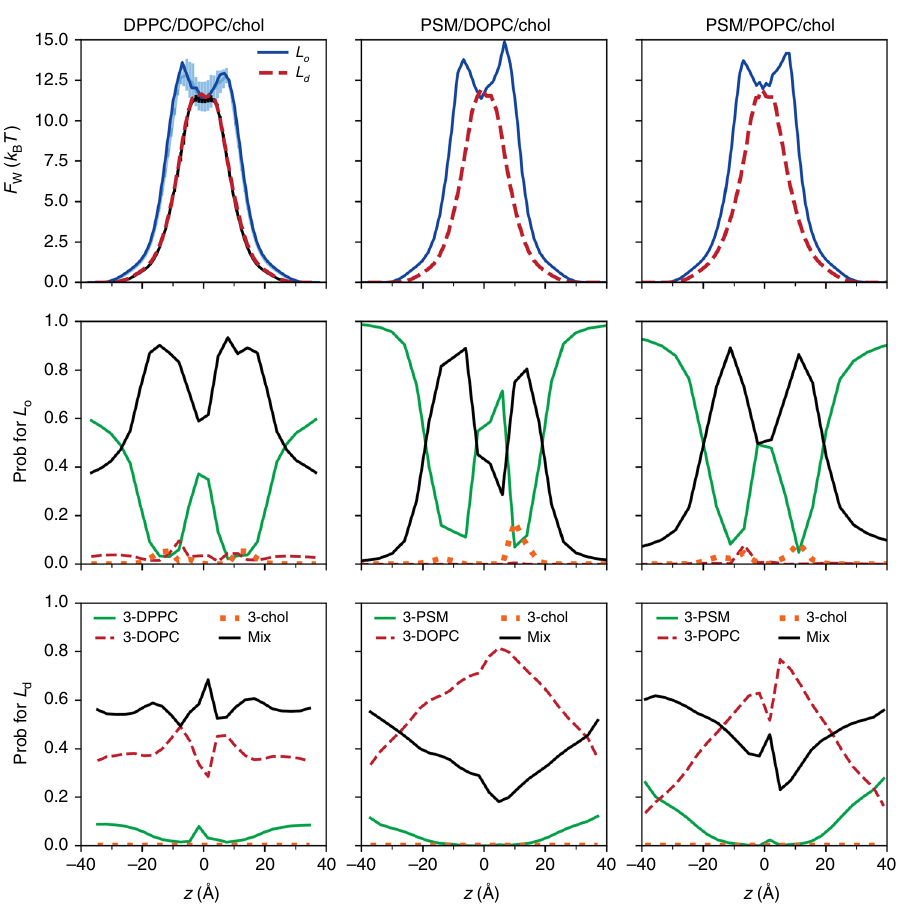
Fig. 5 Comparison of permeation through PSM-containing membranes. Free energy pro fi les for water permeant (top row), probabilities from the three- neighbor analysis of the liquid ordered (middle row) and liquid disordered (bottom row) phases from Anton simulations of DPPC/DOPC/chol (left column), PSM/DOPC/chol (middle column), and PSM/POPC/chol (right column). The light blue and black lines in the top left panel are the PMFs with error bars from the CHARMM simulation of DPPC/DOPC/chol which also included oxygen (Fig. 2). The statistical errors are higher than in Fig. 4 because of the smaller number of saved coordinate sets. Source data are provided as a Source Data fi le.